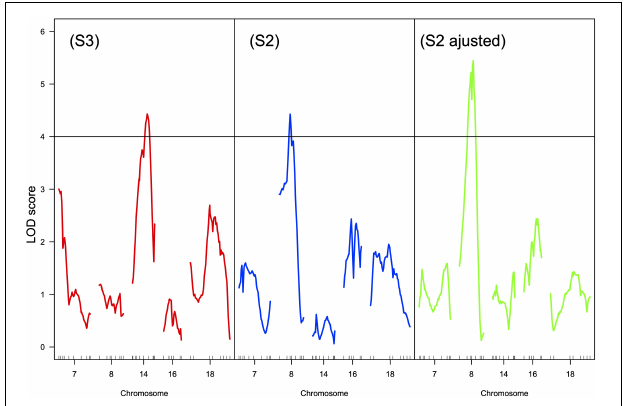
FIGURE 5 | LOD curves for the mean sugar content of the berries over 3 years in progeny from a Riesling × Gewurztraminer cross according to three sampling procedures: (S3) at harvest, same date for all the genotypes, (S2) 230 degree.days (base 10) after mid-véraison, (S2 adjusted) 230 degree.days (base 10) after mid-véraison but adjusted for the fruit to leaf ratio (Duchêne, 2015). The horizontal line is the genome wide LOD threshold at p = 0.05. Small vertical ticks on the X -axis represent the position of molecular markers on the genetic map. Chromosomes 7, 14, 16, and 18 are presented because QTLs for development stages were detected (Duchene et al.,